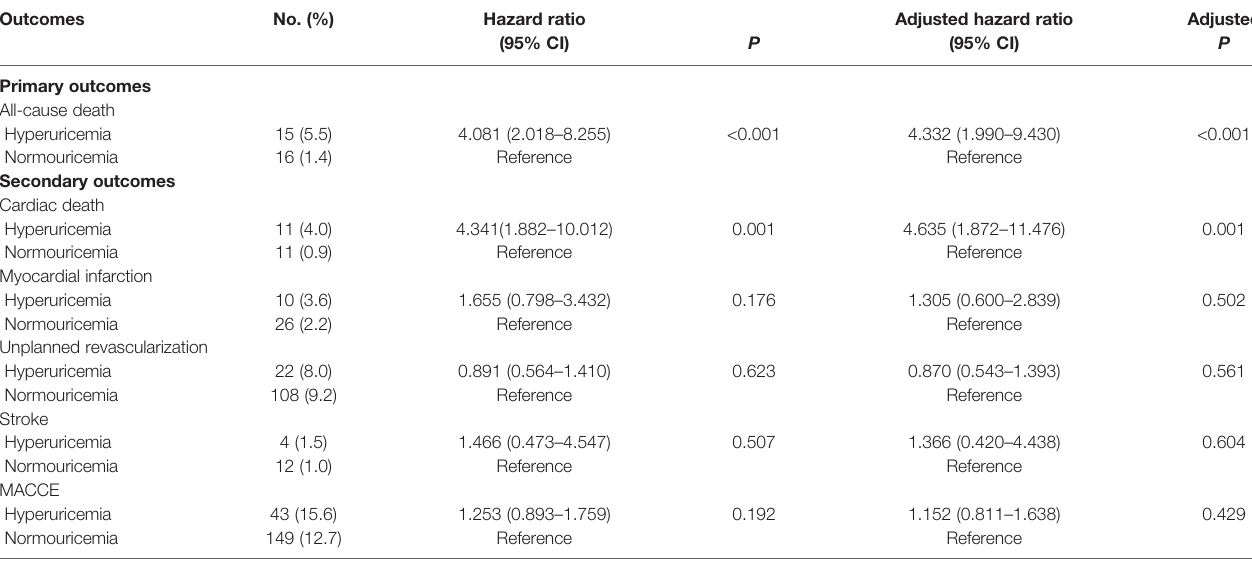
TABLE 2 | Risks of 2-year primary and secondary outcomes in patients with